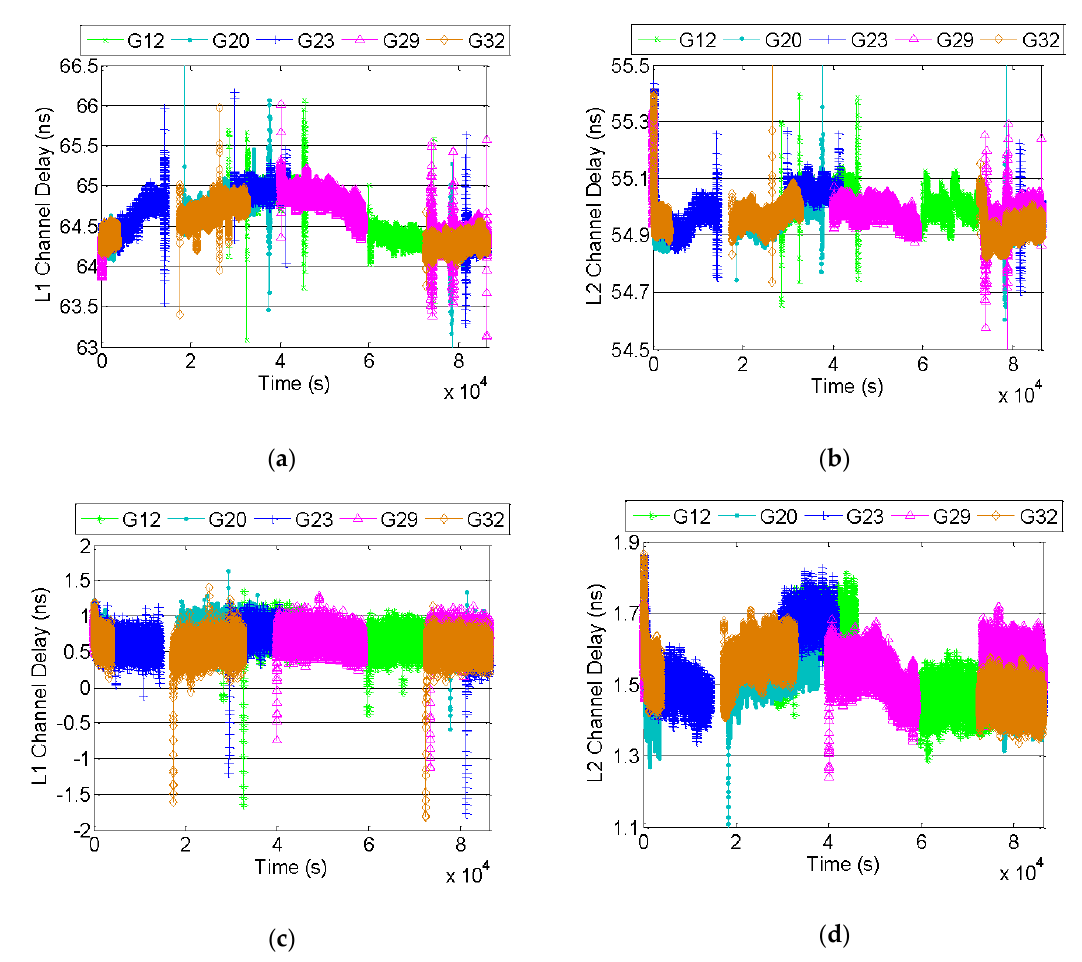
Figure 6. The calibration results of channel delay: ( a ) Novatel-GPS L1; ( b ) Novatel-GPS L2; ( c ) Septentrio-GPS L1; ( d ) Septentrio-GPS L2.